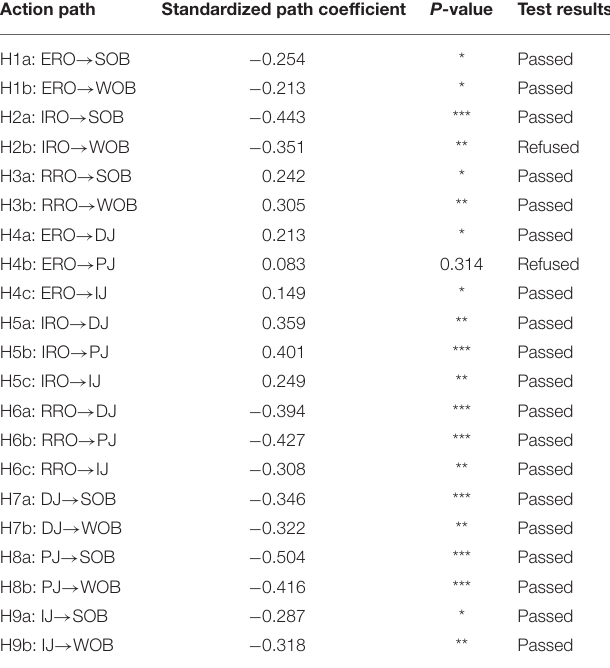
TABLE 5 | Results of hypothesis test. Action path Standardized path coefficient P -value Test